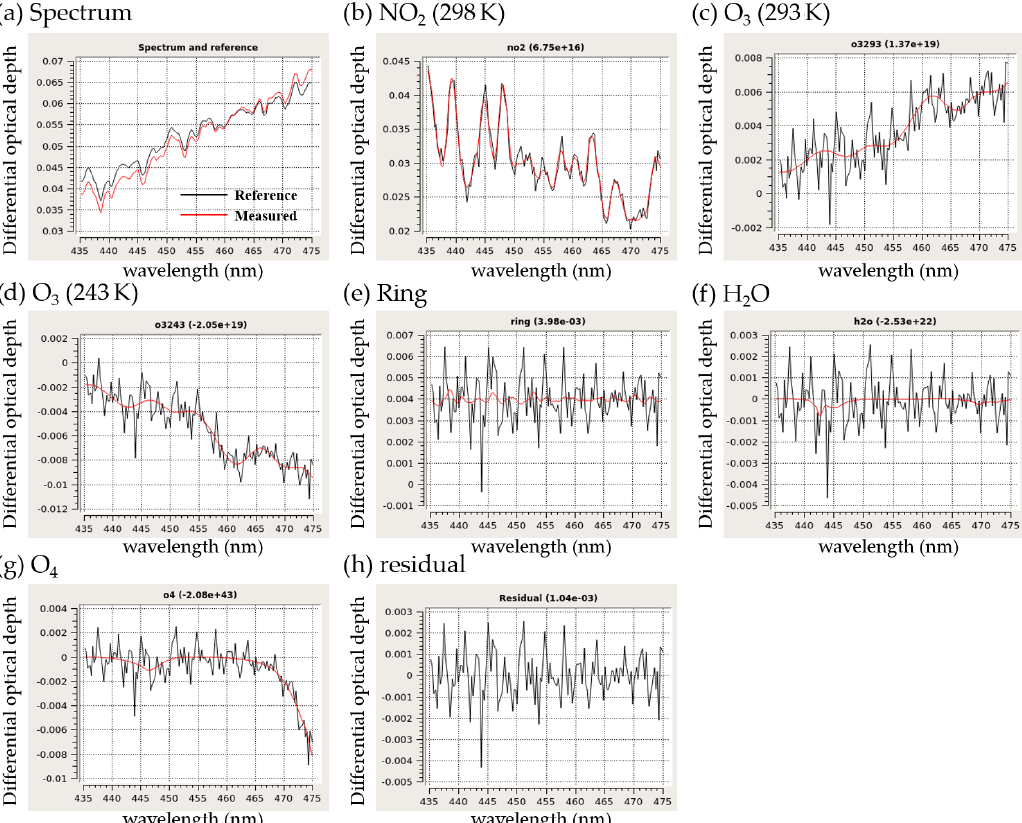
Figure 4. An example of the spectral fitting results of NO 2 retrievals from GeoTASO during the KORUS-AQ campaign (at Gangnam, Seoul on 9 June 2016). The red and black line in panel (a) represent the measured and reference spectrum, respectively. Panels (b) to (h) depict examples of spectral fitting results of (b) NO 2 , (c) O 3 (293K), (d) O 3 (243K), (e) Ring effect, (f) H 2 O, and (g) O 4 , where red and black lines are the absorption cross section of the target species and the fitting residual plus the absorption of the target species, respectively. Panel (h) indicates the fitting residual of this